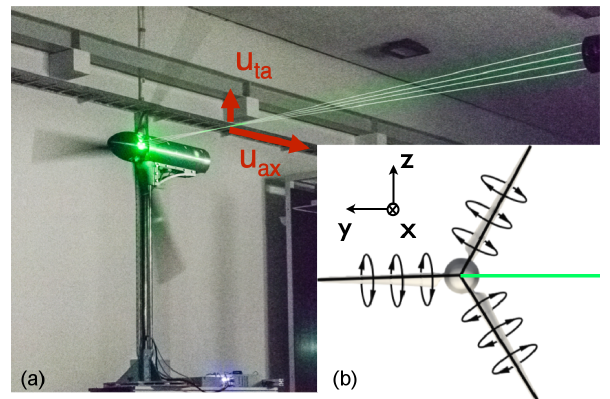
Figure 3. (a) MoWiTO 1.8 with 2D-LDA measurement in the bi- sectrix of two blades of axial and tangential velocity. (b) Counter- balancing of bound circulation for the evenly loaded blades (modi- fied from Herráez et al.,